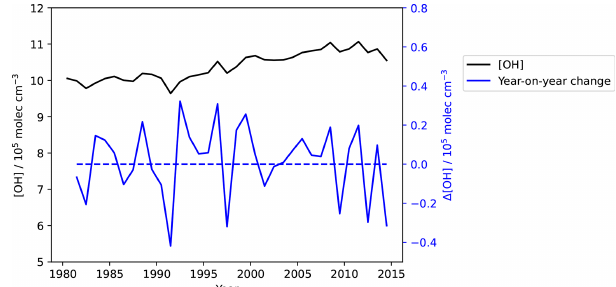
Figure 5. Base OH concentrations plotted on the left-hand y axis (black) and year-on-year changes plotted on the right-hand y axis (blue). In the global average there is a year-on-year change of up to about 0.4molec.cm − 3 yr − 1 , with 13 out the 34 years after 1980, or about one-third of the years, showing a negative year-on-year change. The global IAV is driven by IAV in meteorology-related factors and CO